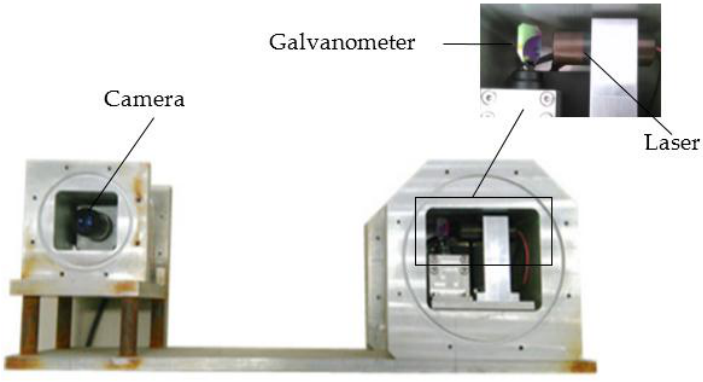
Figure 1. Laser line auto-scanning system.